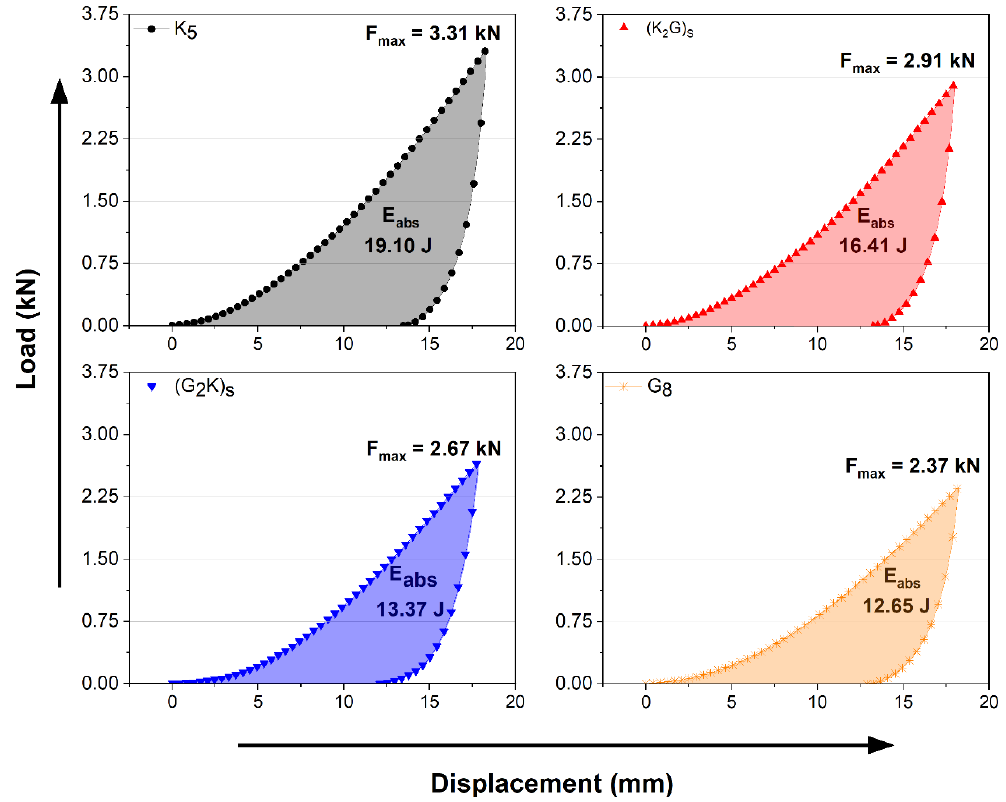
Figure 7. Load/unload QSI results for the laminates.